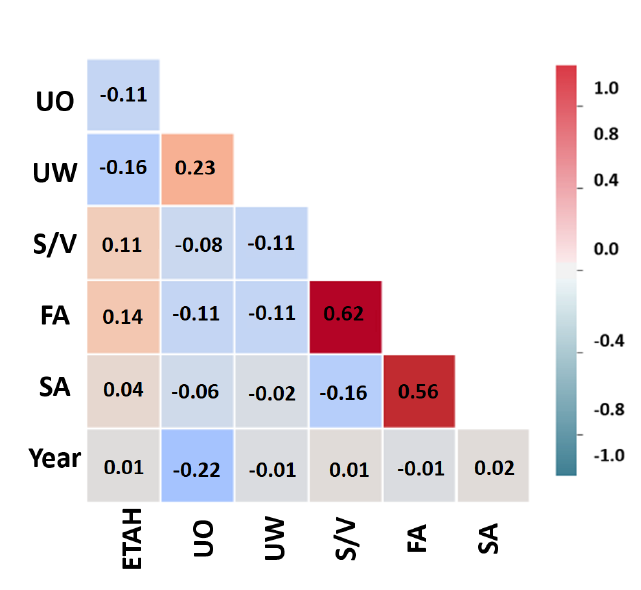
Figure 6. Correlation matrix on the selected